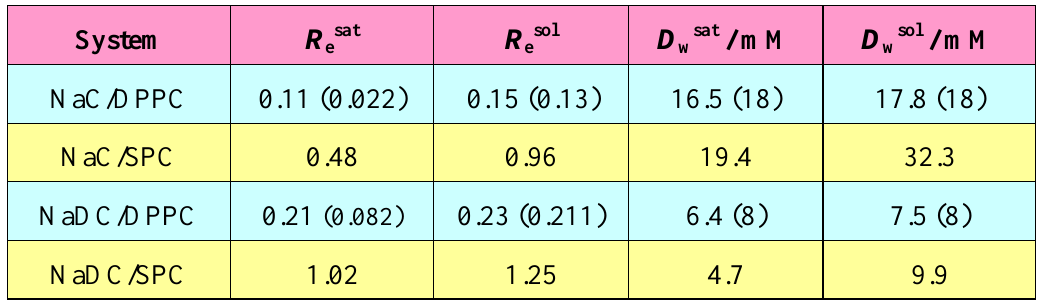
Table 3. NaC and NaDC solubilisation data for DPPC and SPC in water ( pH 7.5) at 60 °C. R : slopes of the saturation (sat) and solubilisation (sol) process, D e concentration. Values reported in parentheses are obtained using the model proposed by Roth et al .